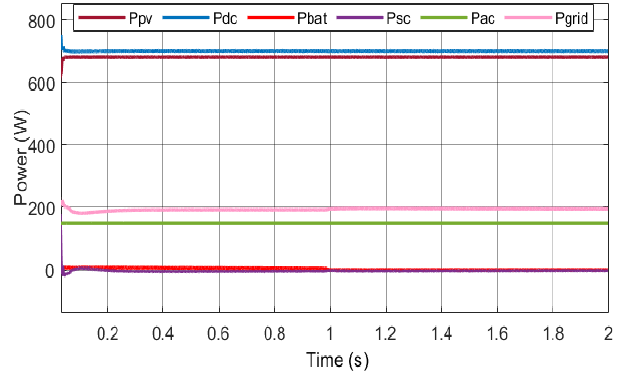
Figure 19. PV, DC load, AC load, grid, and battery power in DPM.